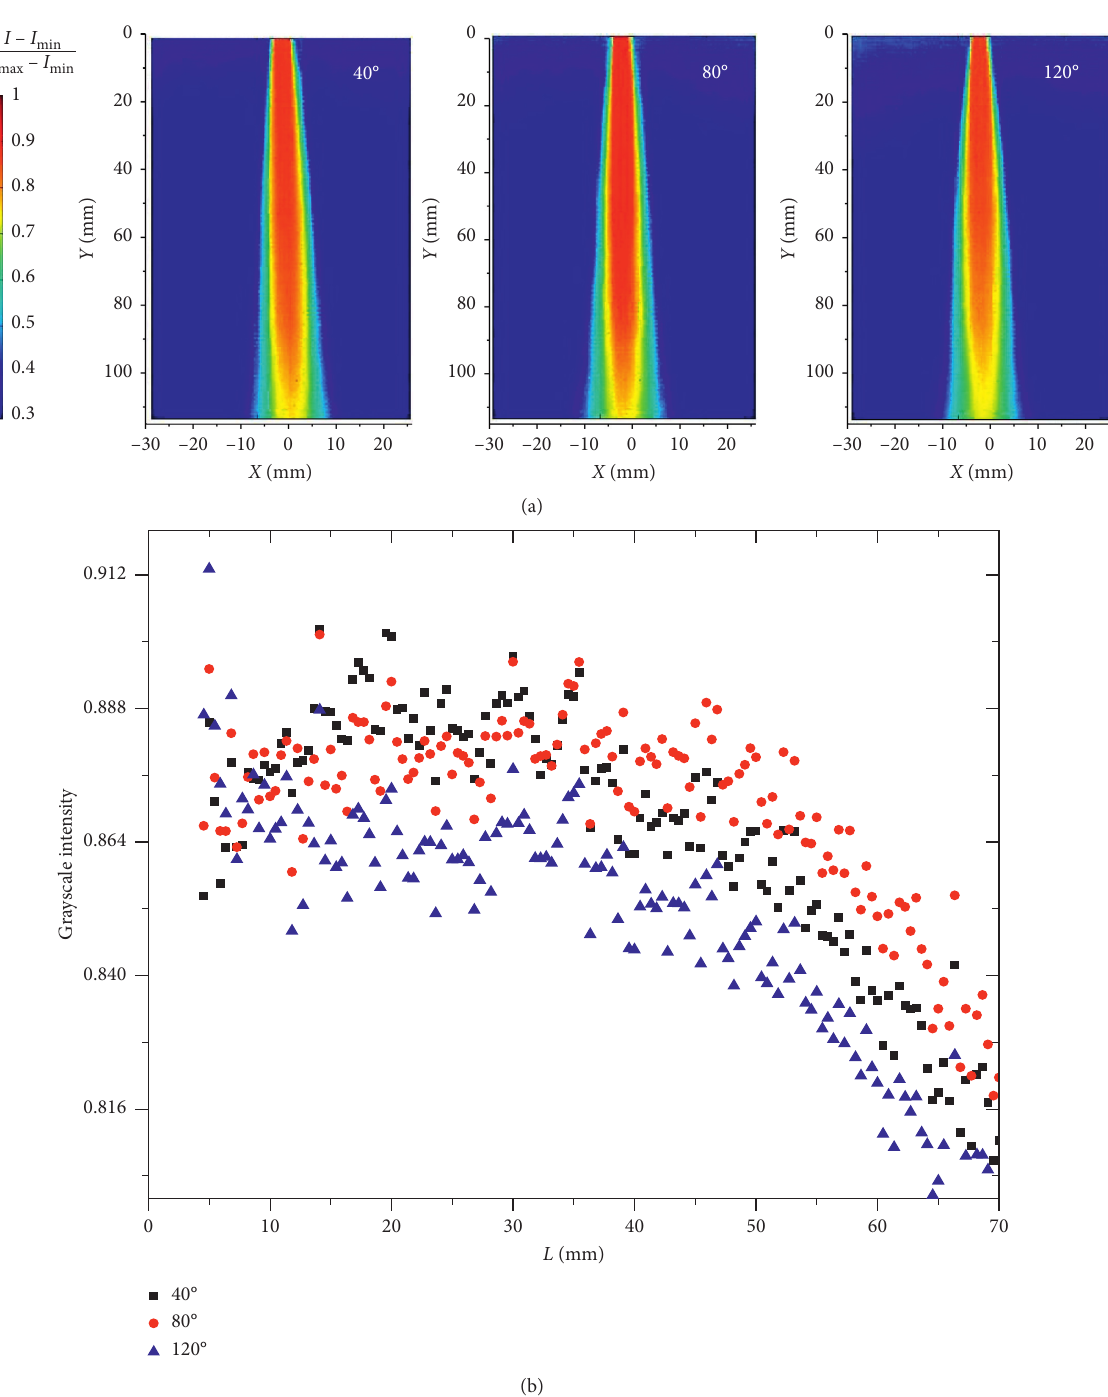
Figure 9: Time-averaged grayscale distribution of the cavitation image with different nozzles ( σ � 0 . 0062). (a) Contour of time-averaged grayscale. (b) Distribution of grayscale values on the central